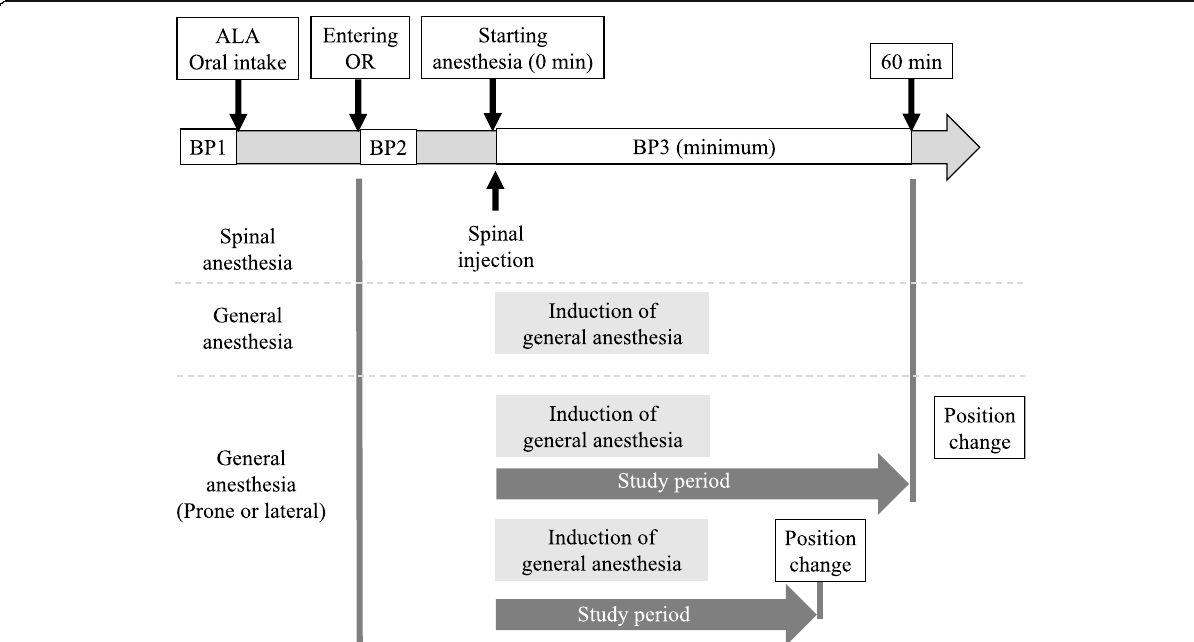
Fig 1 Definition of post-induction period and timing of blood pressure measurement. We defined post-induction period as the initial 60-min period taking place immediately after anesthesia induction. Starting anesthesia (0 min) was initiation of anesthesia induction. If a positional change from a supine to a prone or lateral recumbent position was performed during this 60 min in craniotomy, the study period was then defined as the time from anesthesia induction to just before the positional change. ALA, 5-aminolevulinic acid; OR, operating room; BP1, blood pressure before 5-ALA intake; BP2, blood pressure when entering operating room (before anesthesia induction); BP3, blood pressure